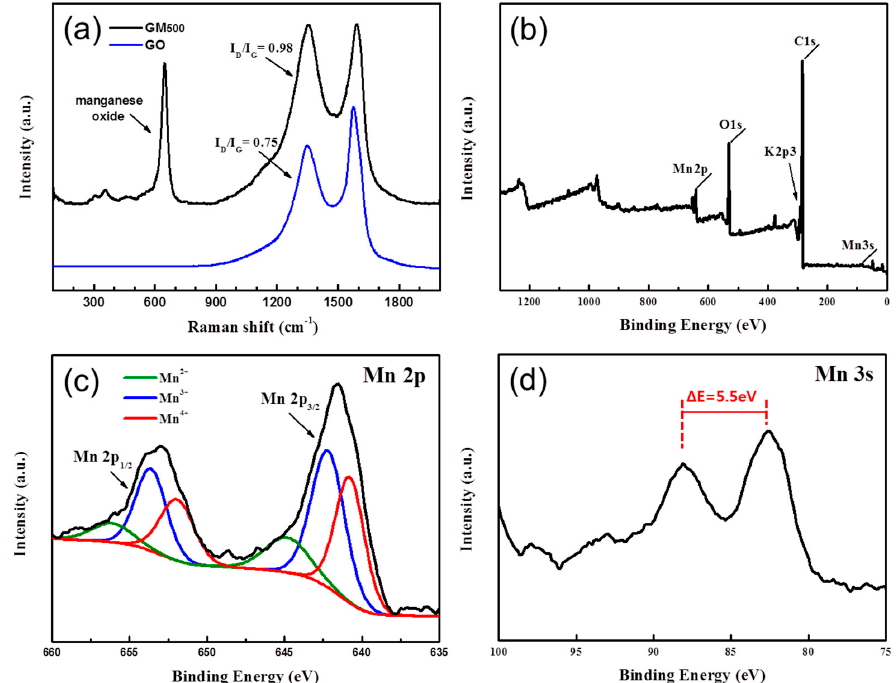
Figure 4. ( a ) Raman spectra of the GO and GM 500 . ( b ) X-ray photoelectron spectroscopy (XPS) survey scan of GM 500 . ( c ) Mn 2p region, and ( d ) Mn 3s region of GM 500 .